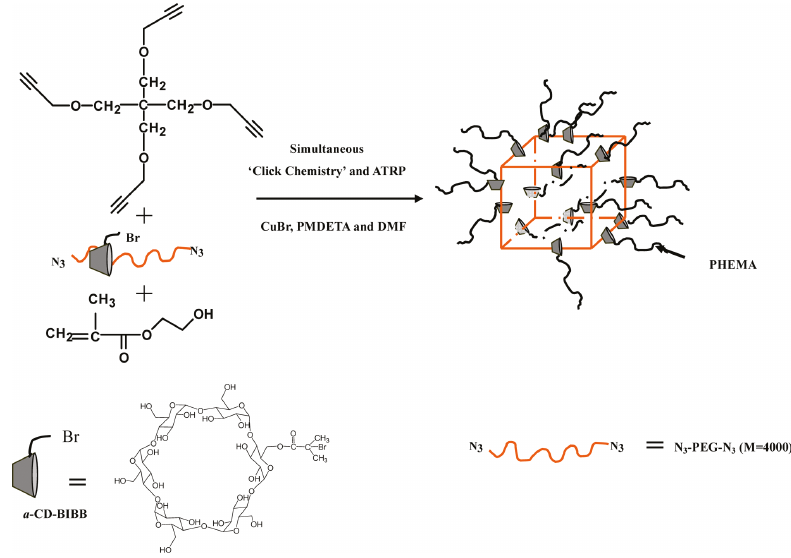
Figure 12. Sliding-graft interpenetrating polymer network synthesized by concurrent ATRP and CuAAC click chemistry. Adapted with permission from [70], Copyright© 2010 American Chemical